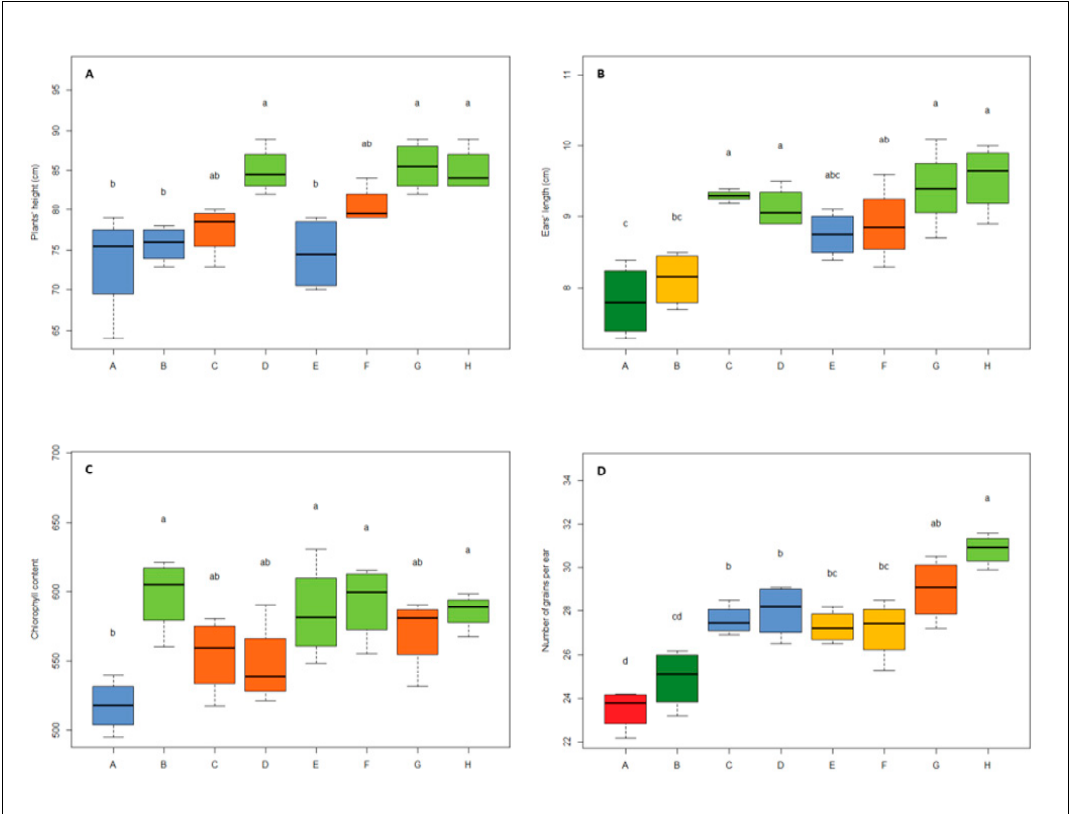
Figure 5. ( A ) Plant height (PH); ( B ) ear length (EL); ( C ) chlorophyll content (CH); ( D ) number of grains per ear (NG) of wheat: concentrations (ASA3, ASA5) *terms of applications (T1 / T2, T3 / T4) *years (2013, per ear (NG) of wheat: concentrations (ASA3, ASA5) *terms of applications (T1/T2, T3/T4) *years 2014). Boxes: the interquartile range. Lines across the boxes: the average of the values. The line above and below the vertical dashed lines: the maximum and minimum values. Boxes of the same